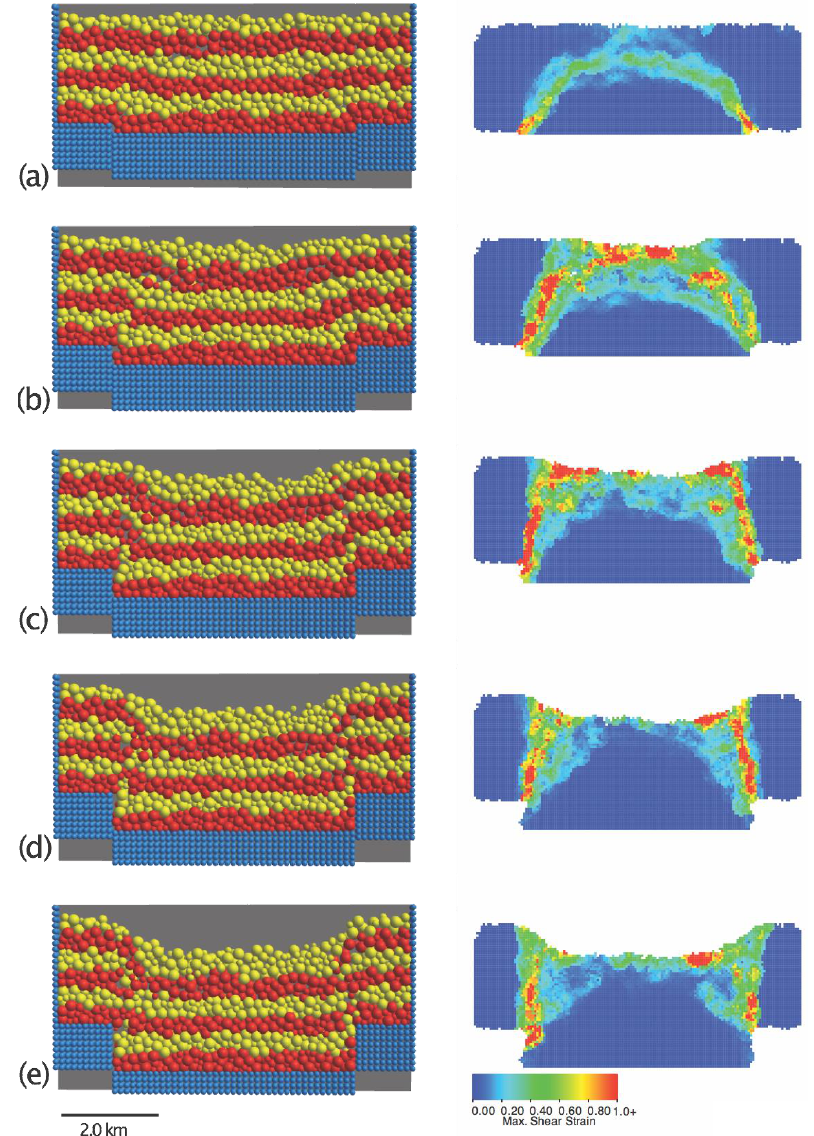
Figure 9. Evolution of vertical section A: caldera geometry (left) and incremental shear strain accrued during the preceding 200 m of basal subsidence (right) at ( a ) 200, ( b ) 400, ( c ) 600, ( d ) 800, and ( e ) 1000 m basal subsidence for an experiment with a flat, rectangular roof.